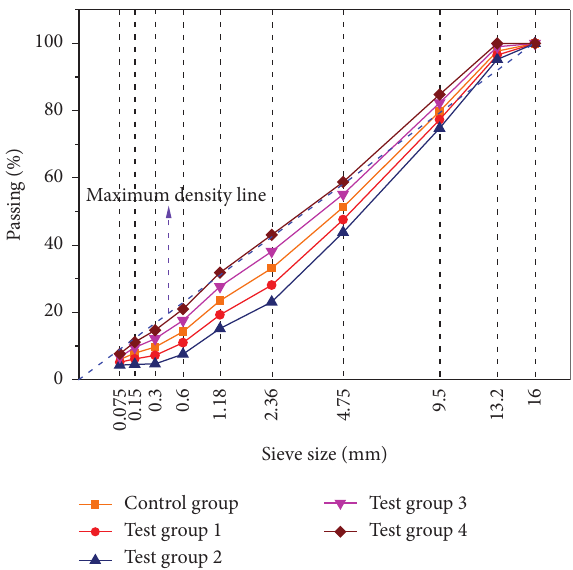
Figure 5: Four levels of gradation segregation designed in this study.